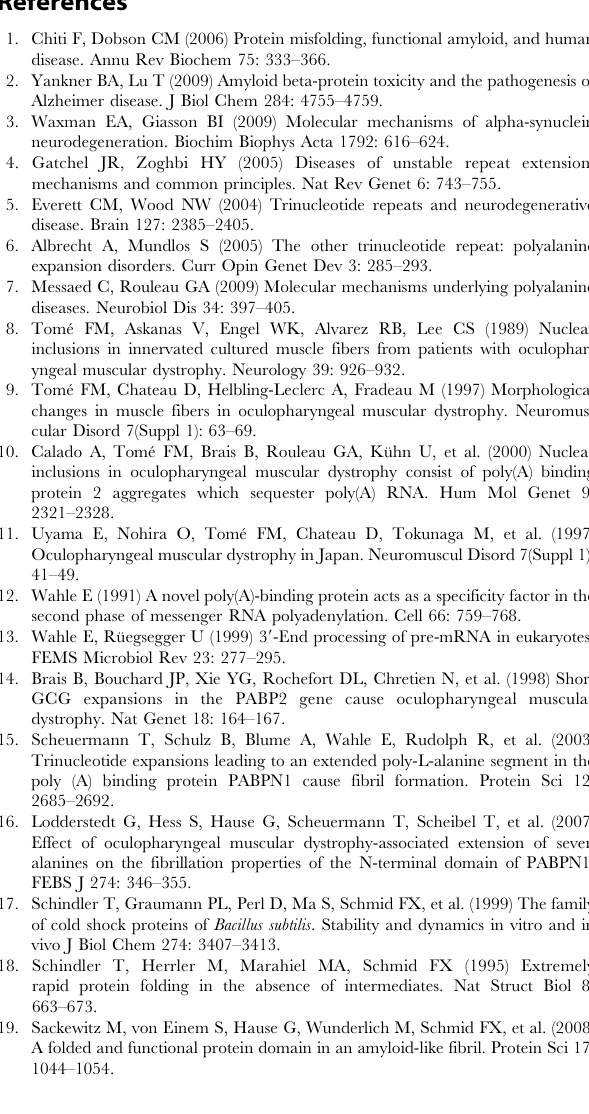
with the L3 linker, dashed line and with L16 linker, dotted-dashed line. As a reference, the spectrum of MCspB is shown in the black, solid line. In B , variants with 10 alanines are shown by filled symbols, variants with 17 alanines by open symbols; variants with L3 linkers are indicated by circles, variants with L16 linkers by triangles. The corresponding K D values are listed in table